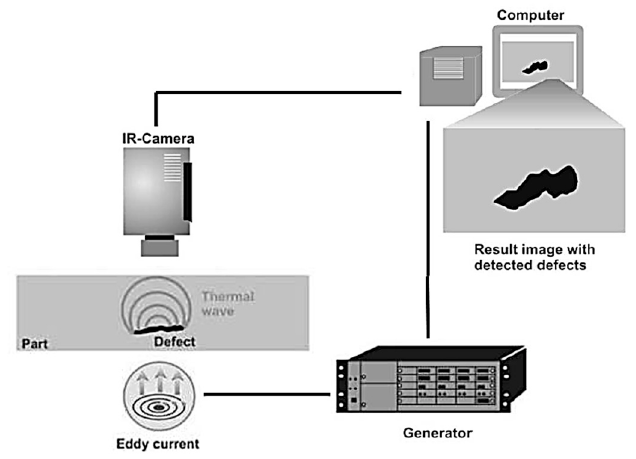
Figure 19. An illustration of eddy current thermography [118].